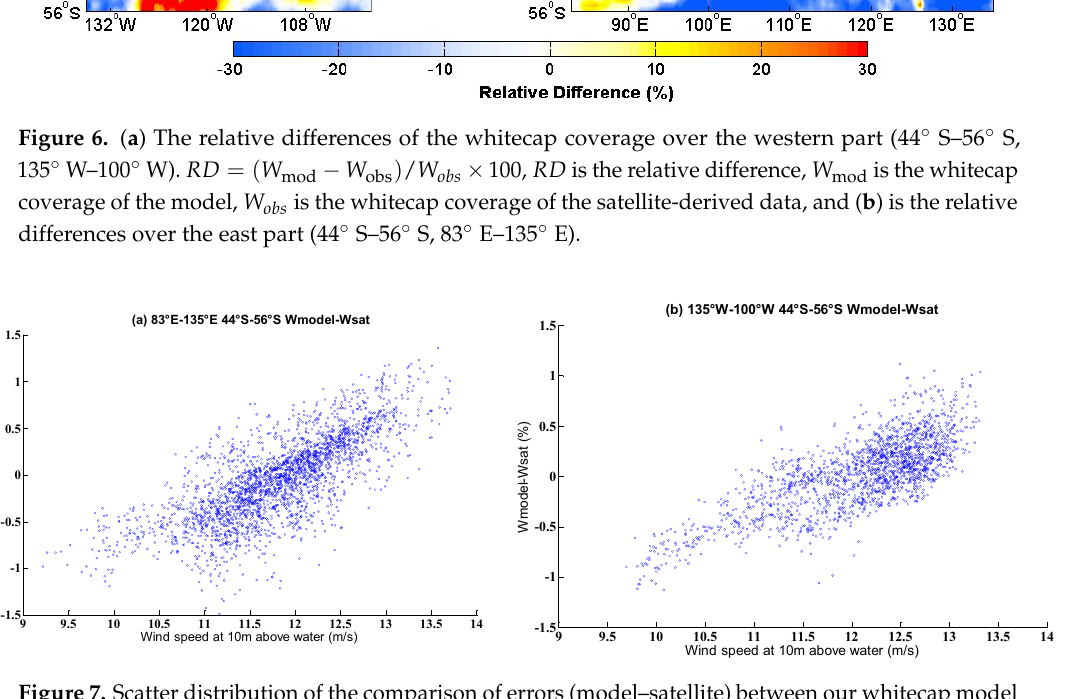
Figure 7. Scatter distribution of the comparison of errors (model–satellite) between our whitecap model and satellite data, over ( a ) 44° S–56° S, 135° W–100° W and ( b ) 44° S–56° S, 83° E–135° E.